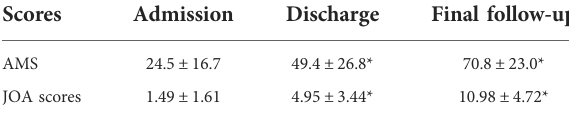
TABLE 4 AMS and JOA scores at admission, discharge and